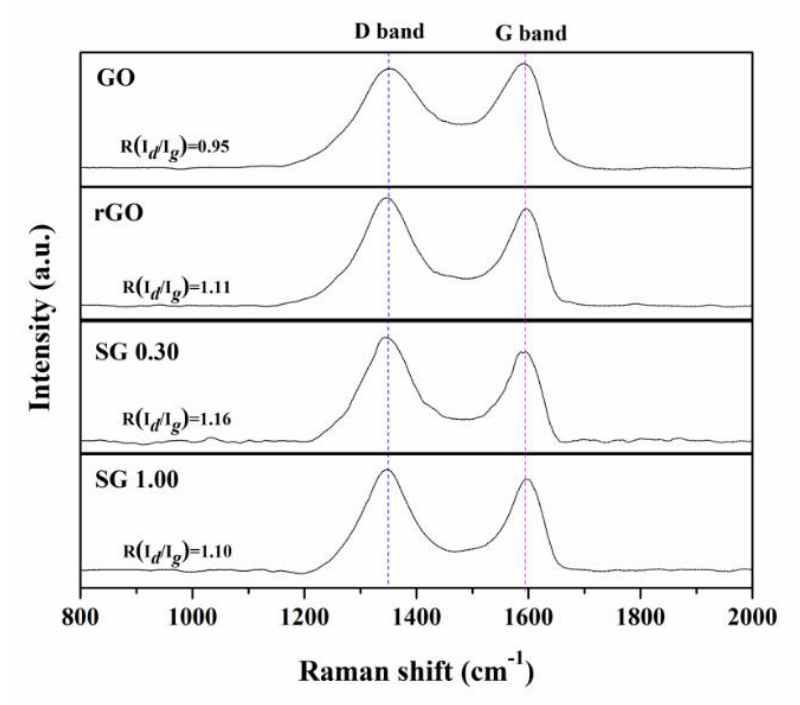
Figure 6. Water adsorption/desorption isotherms of the ( a ) SiO 2, ( b ) SG 0.30, and ( c ) SG 1.00 samples at 298 K.